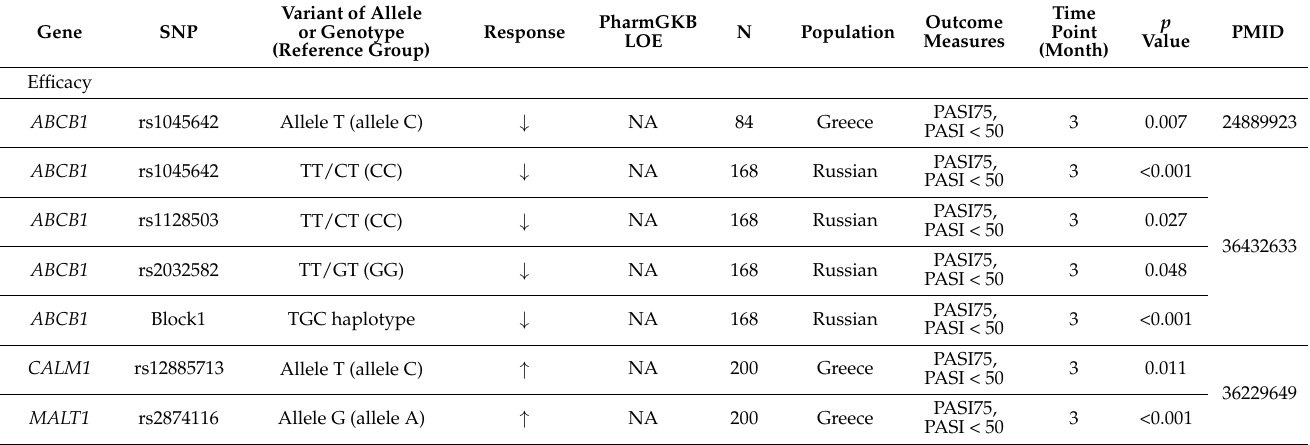
Table 3. Genetic polymorphisms associated with response of cyclosporin in patients with psoriasis.